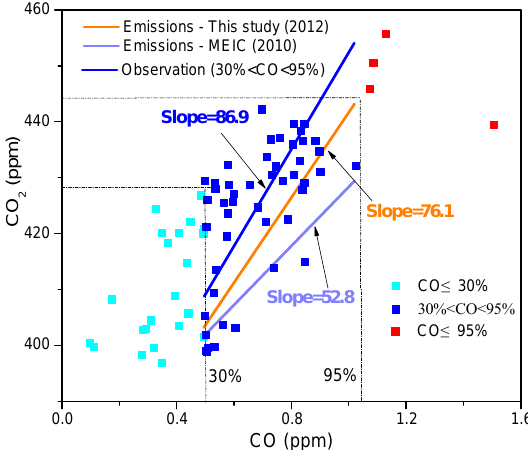
Figure 9. The correlation of daily CO 2 and CO concentrations at Caochangmen site and the emission ratios of CO 2 to CO from bottom-up inventories for Nanjing, 2012. The wintertime concen- trations with CO between the 30th and 90th percentiles are used for the correlation